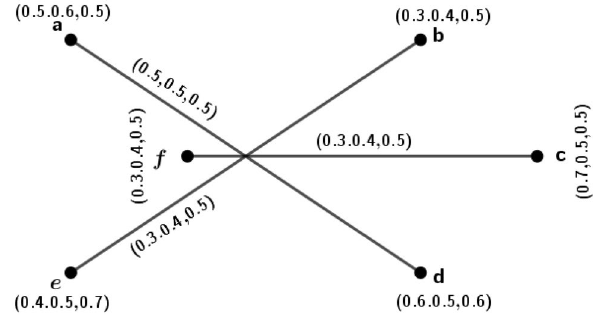
Figure 12. Antipodal 3PFG A (Γ )